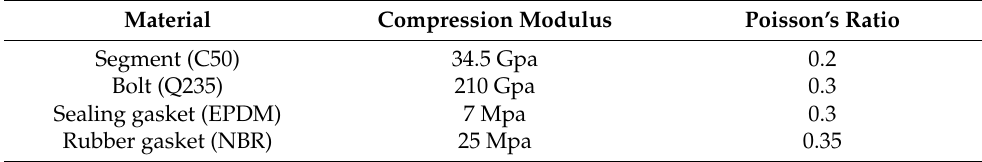
Table 1. Material parameters in circumferential